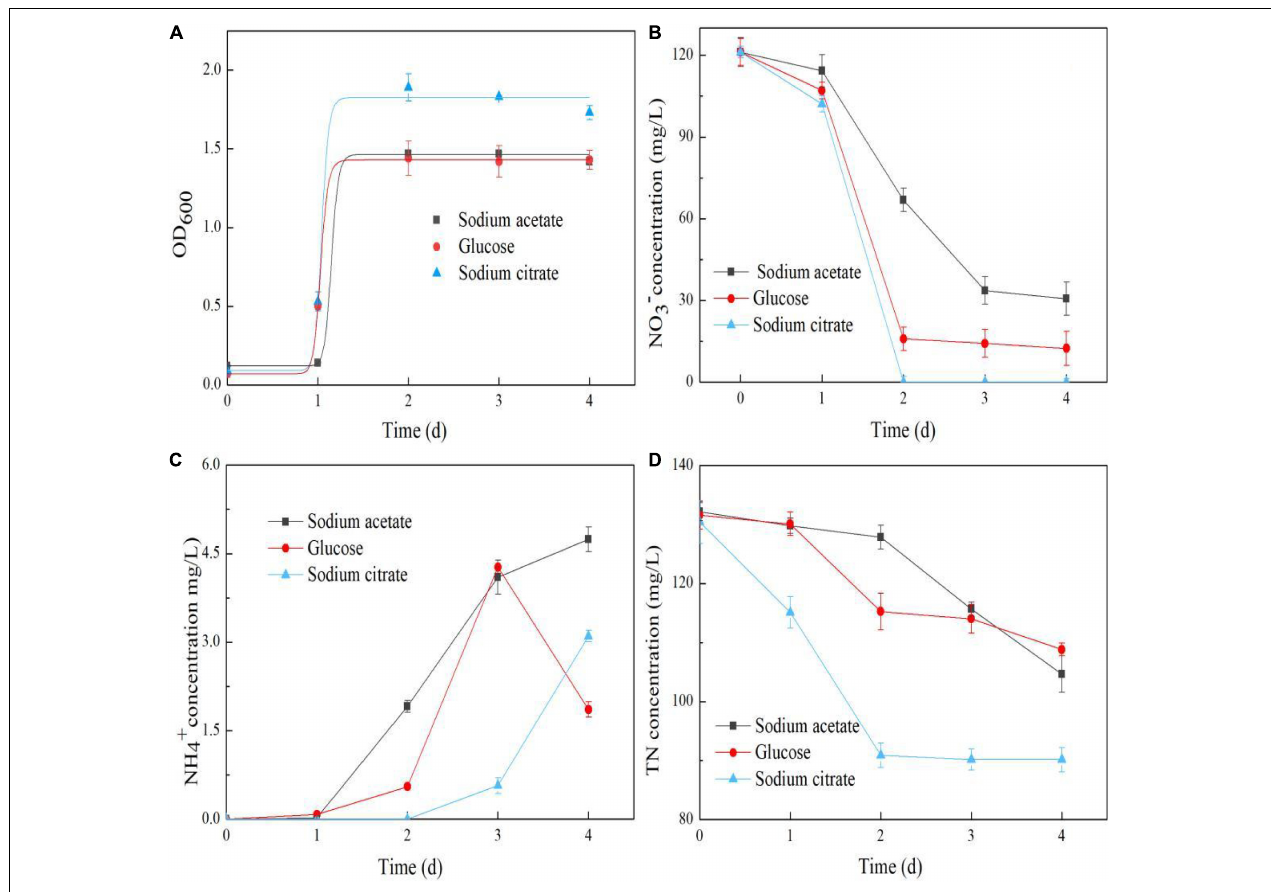
FIGURE 1 | Effects of carbon type on the OD 600 (A) , NO 3 − concentration (B) , NH 4 + concentration (C) , and TN concentration (D) in the Pseudomonas putida Y-9 culture.